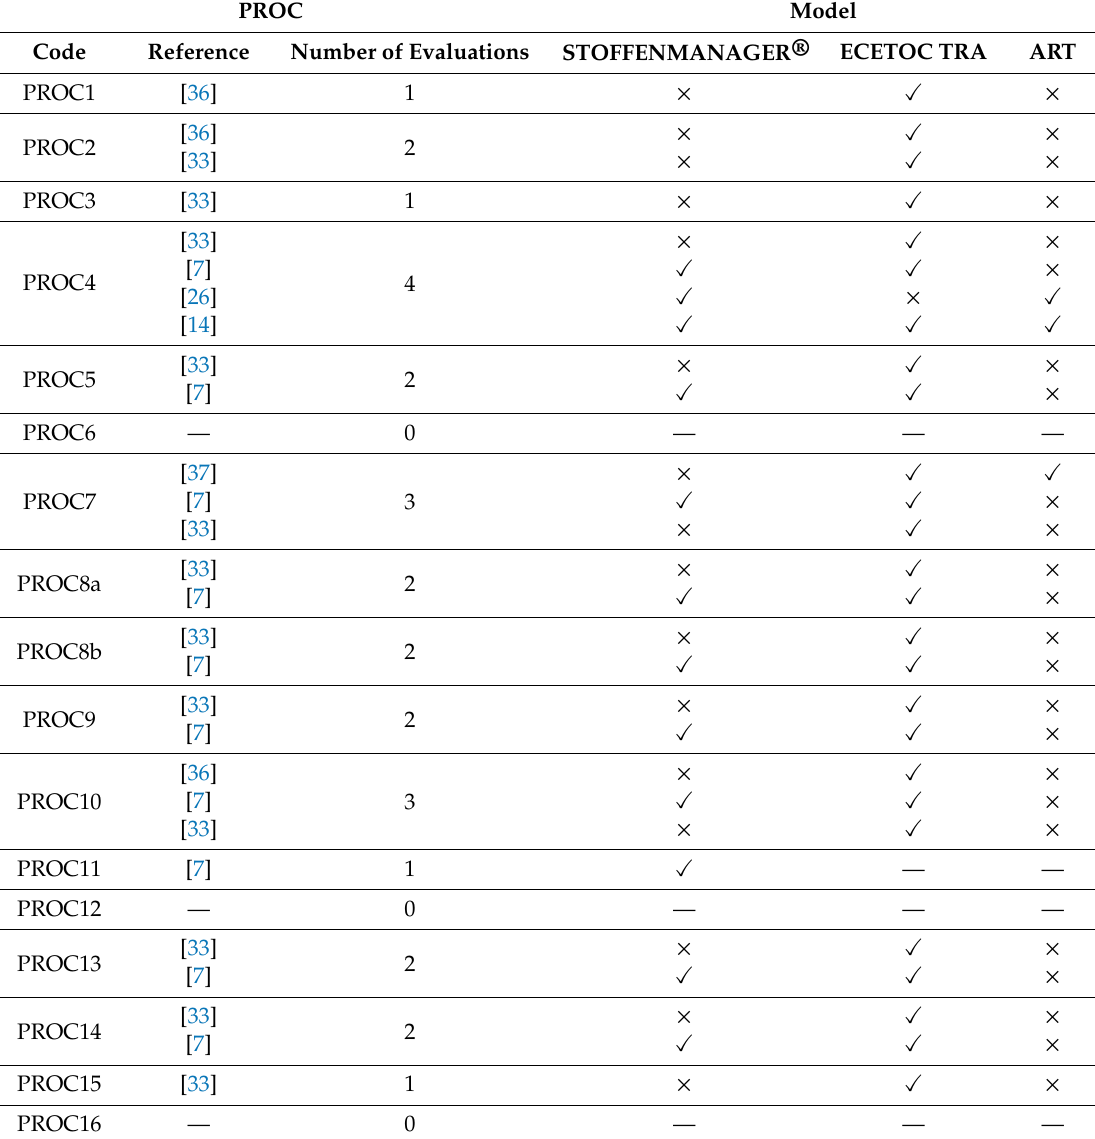
Table 3. Summary of Process Categories (PROCs) evaluated ( (cid:88) ) by means of different models (STOFFENMANAGER ® , ECETOC TRA-European Centre for Ecotoxicology and Toxicology of Chemicals Targeted Risk Assessment, and ART-Advanced Registration, Evaluation, Authorization and Restriction of Chemicals (REACH) Tool) or not evaluated ( × ). Complete definition of PROCs could be found in [1,35] and in Supplementary Material (Table